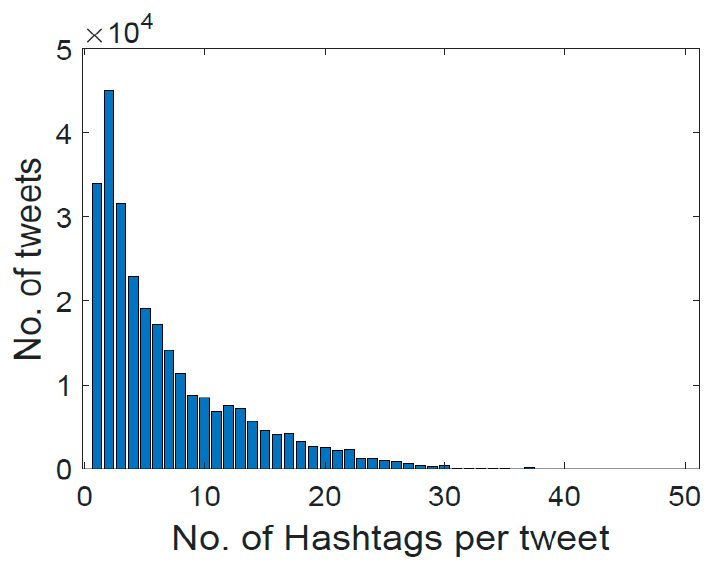
Figure 5. Hashtags per tweet.